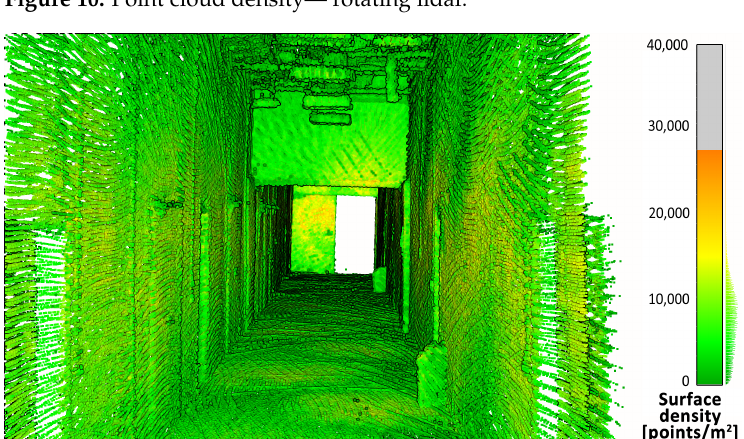
Figure 10. Point cloud density— rotating lidar.